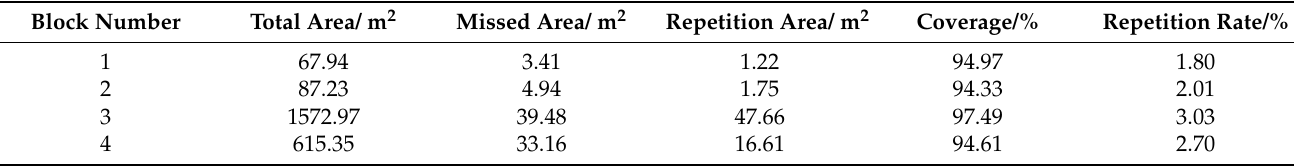
Table 4. Validation of the test results of the experiment.